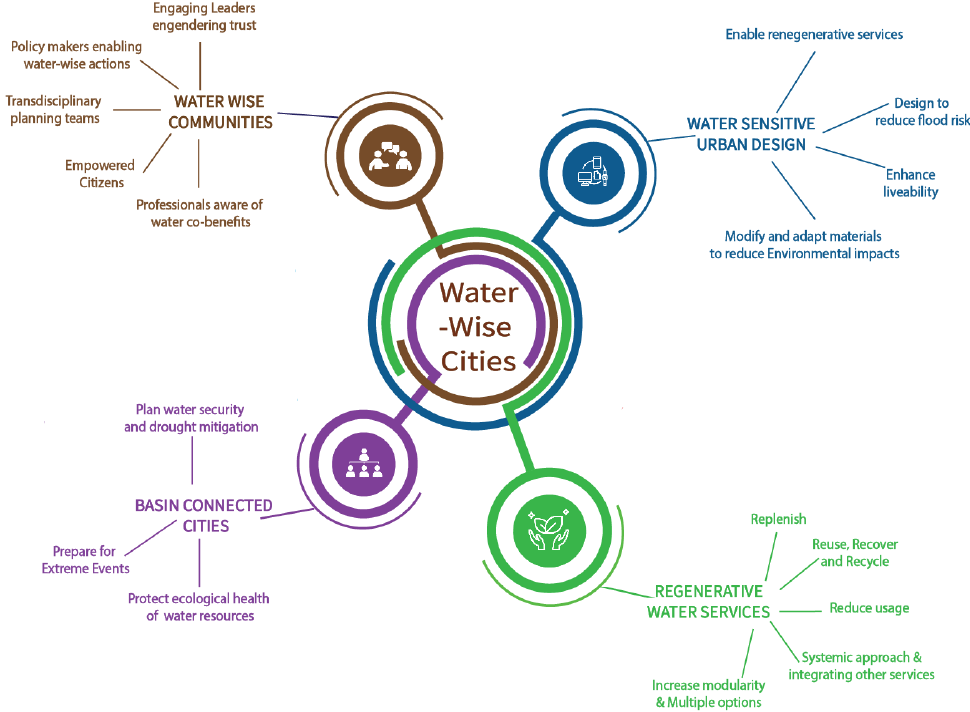
Figure 4. Water-wise framework by IWA re-aligned to STEEPI framework.